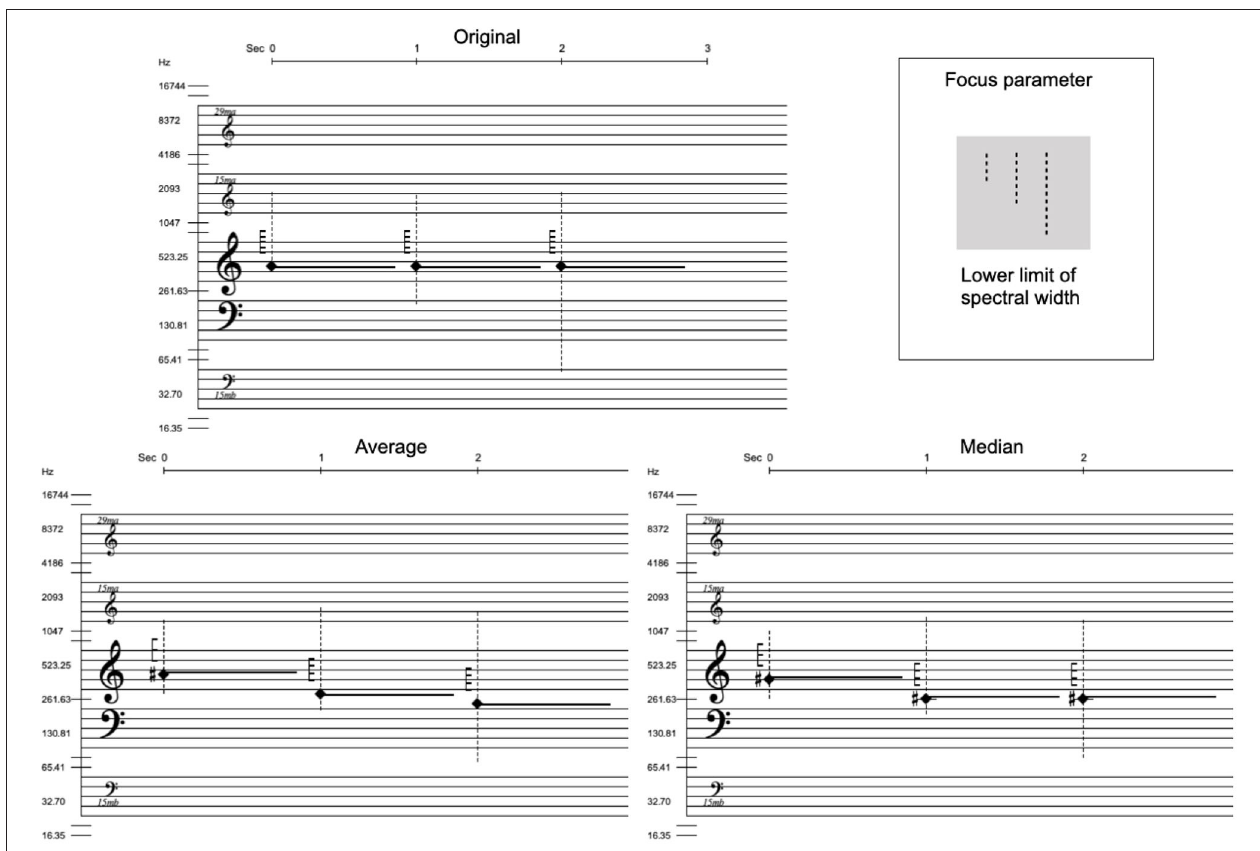
FIGURE 6 | Comparison of the original sonified notation and notation generated from the average and median data retrieved from the hand drawn notation. This is question 7 in the original set of 16 questions, and the parameter in focus is the lower limit of spectral width.